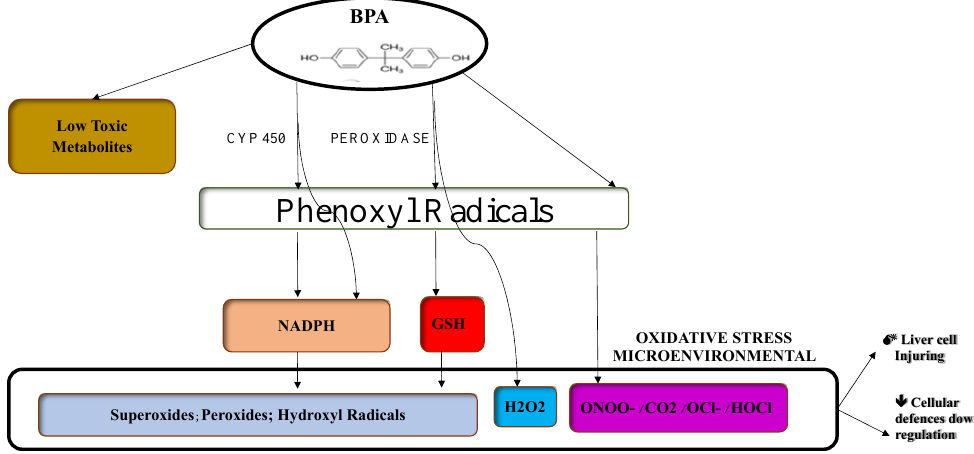
Figure 3. BPA-induced oxidative stress